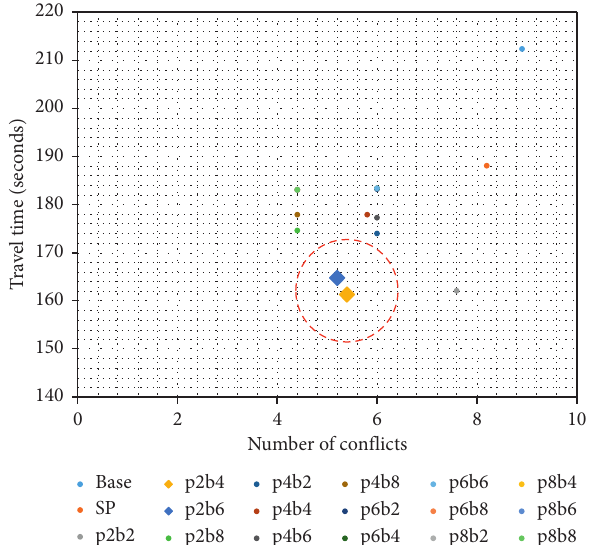
Figure 7: Multiobjective scatter